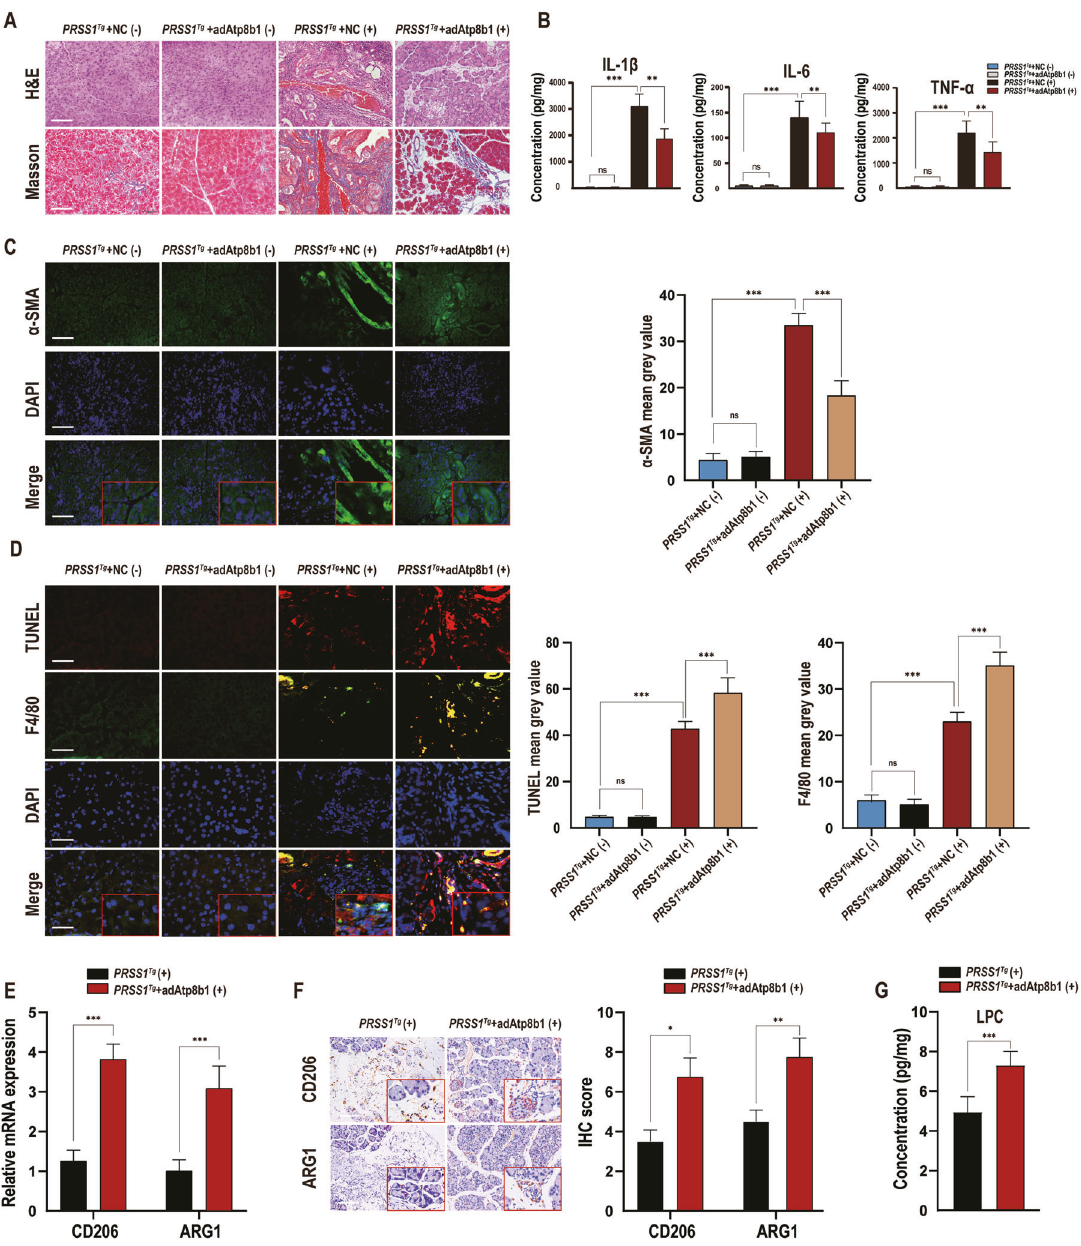
Fig. 3 Atp8b1 reverses the impairment of efferocytosis and dysregulation of phospholipid metabolism in acinar cells during CP development. AdAtp8b1 was used to induce Atp8b1 overexpression in the pancreas of PRSS1 Tg mice. The pancreases of PRSS1 Tg mice were infected with adenoviral vectors harbouring a scrambled adRNA for the negative control (NC). A Structural alterations and fi brosis in pancreatic tissues from adAtp8b1 and NC groups PRSS1 Tg mice treated ( + ) or untreated ( − ) with caerulein were evaluated by H&E staining and Masson ’ s trichrome staining, respectively. B The levels of IL-1 β , IL-6, and TNF- α in pancreatic tissues from caerulein-treated and untreated PRSS1 Tg mice were quantitatively analyzed by ELISA. C α -SMA expression in pancreatic tissues from caerulein-treated and untreated PRSS1 Tg mice was detected by immuno fl uorescence staining, the mean gray values calculated by ImageJ were used to quantitatively analyze the degree of fi brosis. The mean gray values was calculated using integrated density divided by area. D Apoptosis and F4/80 expression were detected by a TUNEL assay and immuno fl uorescence staining, respectively, in pancreatic tissues from caerulein-treated and untreated PRSS1 Tg mice. The mean gray values calculated by ImageJ were used to quantify these parameters. E The mRNA expression of CD206 and ARG1 in the pancreatic tissues from adAtp8b1-treated and untreated PRSS1 T g CP mice was measured by RT-PCR. F Immunohistochemical staining was used to detect CD206 and ARG1 expression in pancreatic tissues from adAtp8b1-treated and untreated PRSS1 T g CP mice. G The concentration of LPC in pancreatic tissues from adAtp8b1-treated and untreated PRSS1 T g CP mice was assessed by LC – MS/MS. PRSS1 Tg ( + ) and PRSS1 Tg ( − ) represented mice treated and untreated with caerulein, respectively. The data are presented as the means ± SDs. ns no signi fi cant difference; * p ≤ 0.05; ** p ≤ 0.01; *** p ≤ 0.001. Scale bars = 100 µm.